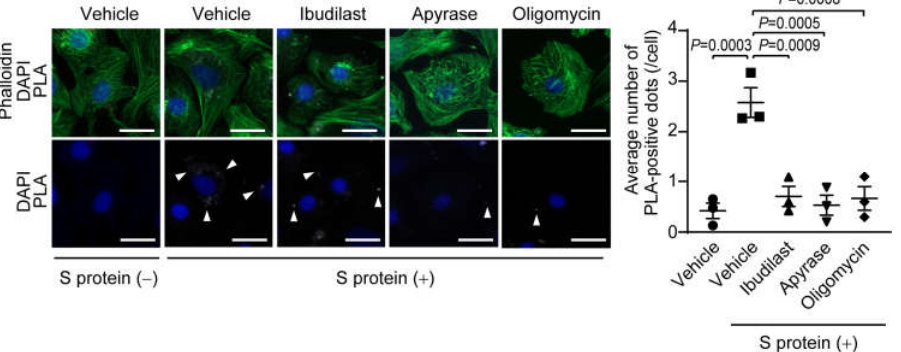
Figure 5. S protein exposure induces TRPC3-Nox2 complex formation through ATP release. Repre- sentative images of TRPC3-Nox2 complex formation in NRCMs treated 3 h after S protein (50 nM) exposure (left). NRCMs were treated with Apyrase (2 U/mL) or oligomycin (1.5 µM) 1 h before S protein exposure. PLA signals between TRPC3 and Nox2 antibodies are shown as white spots (arrowheads), counterstained with phalloidin (green) and DAPI (blue). Scale bars = 20 µm. Average number of PLA signals for each cell was quantified in left panel (right). At least 50 cells were counted. All data are shown as mean ± SEM; n = 3. Significance was imparted using one-way ANOVA followed Tukey’s comparison test.